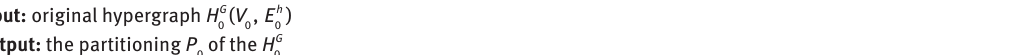
Algorithm 1: The Multi-Level Method Based on the Discrete